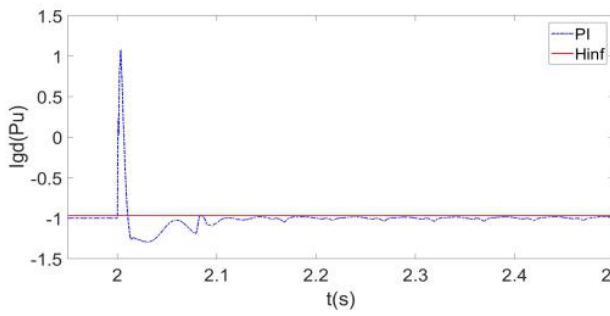
Figure 35. The influence of k i2 on i gd.